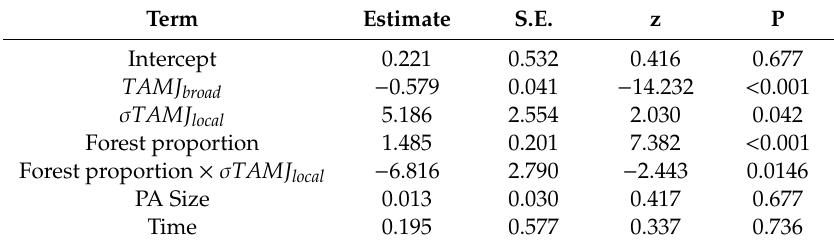
Table 2. Results of generalized linear mixed modelling (GLMM; assuming negative-binomial errors with a log-link function) of bird population densities in PAs. Bird densities were modelled using broad-scale air temperature variation ( TAMJ broad ), local air temperature variability ( σ TAMJ local ), forest proportion, interaction between σ TAMJ local and forest proportion and PA size as predictors. Species were considered in the models as random factors. Predictor Time shows the division of data into two distinct parts. The protected area size was log-transformed prior to the analysis. Term Estimate S.E. z P Intercept 0.221 0.532 0.416 0.677 TAMJ broad − 0.579 0.041 − 14.232 < 0.001 σ TAMJ local 5.186 2.554 2.030 0.042 Forest proportion 1.485 0.201 7.382 < 0.001 Forest proportion × σ TAMJ local − 6.816 2.790 − 2.443 0.0146 PA Size 0.013 0.030 0.417 0.677 Time 0.195 0.577 0.337 0.736